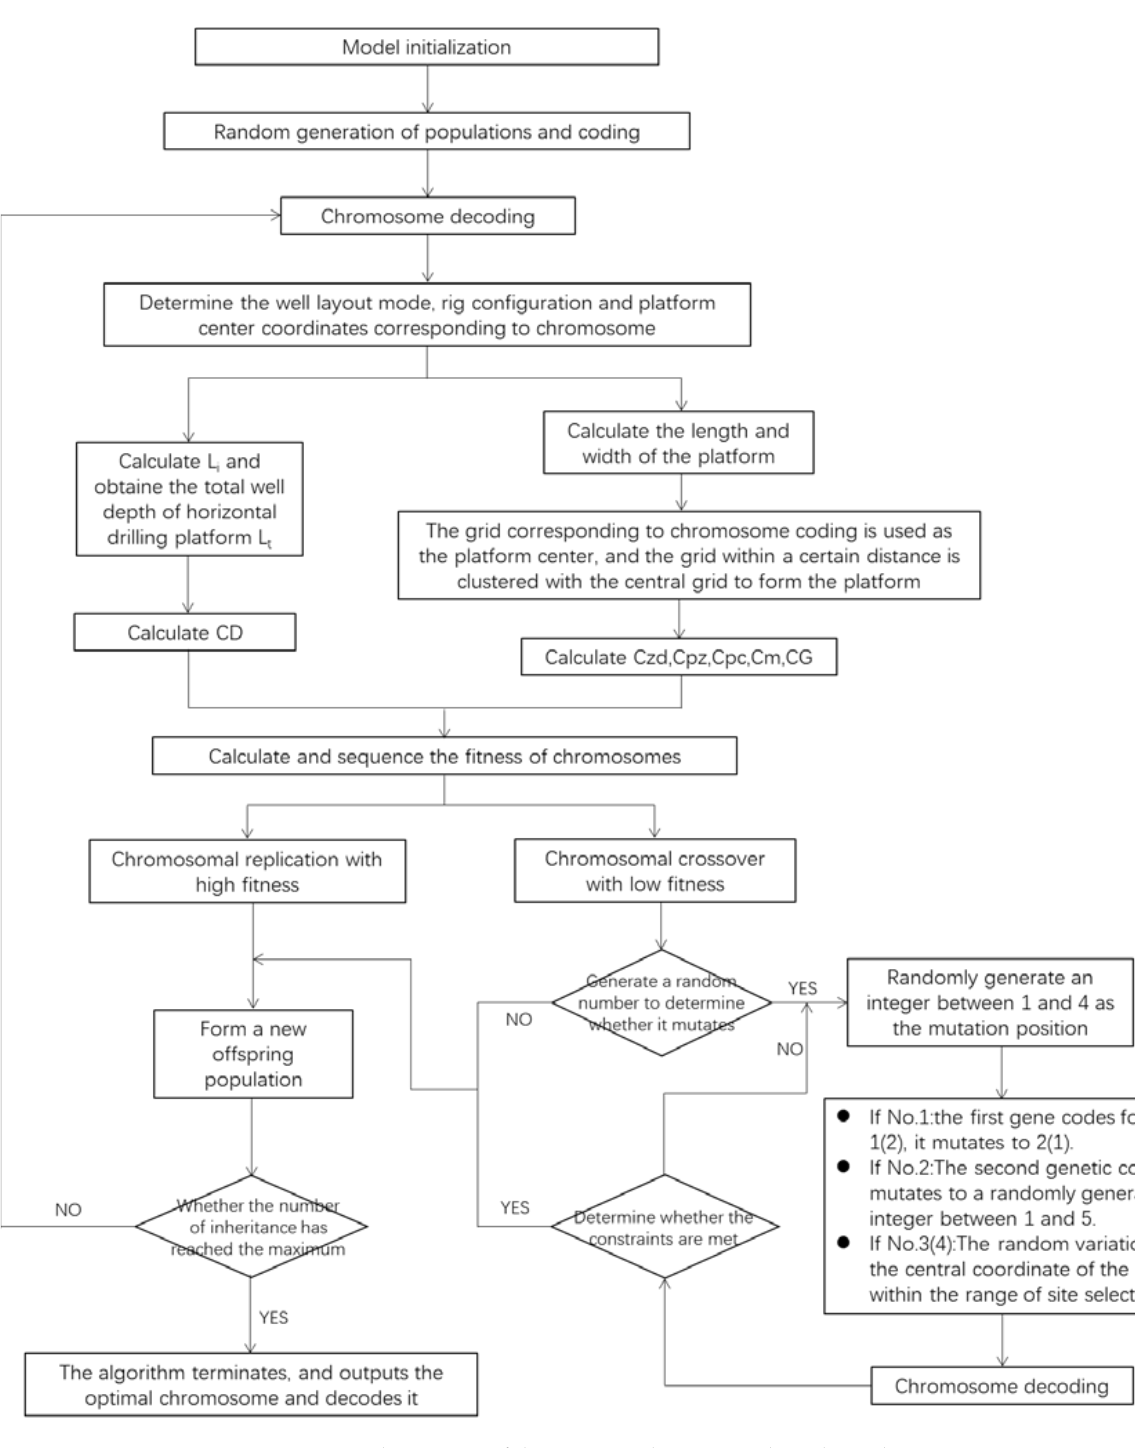
Figure 2. The process of determining the genetic algorithm